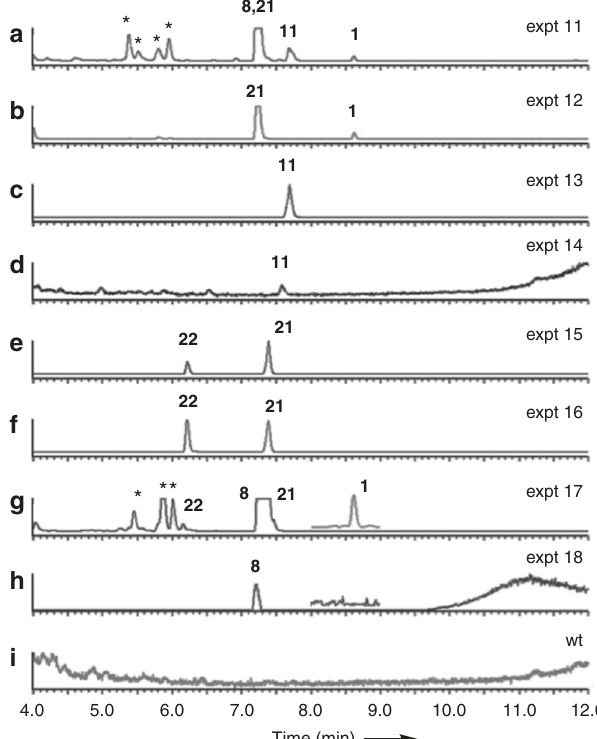
Fig. 6 LCMS evaporative light-scattering (ELS) chromatograms of organic extracts of A. oryzae NSAR1 expression strains (arbitrary units). a A. oryzae NSAR1 + stpks1 + str2 + str3 + str4 + str11 + str8 + str10 + str9 + stl2 ; b A. oryzae NSAR1 + stpks1 + str2 + str3 + str4 + str11 + str8 + str10 + str9 ; c A. oryzae NSAR1 + stpks1 + str2 + str3 + str4 + str11 + str8 + str10 ; d A. oryzae NSAR1 + stpks1 + str2 + str3 + str4 + benzoyl SNAC 9 ; e A. oryzae NSAR1 + stpks1 + str11 + str8 + str10 + str9 + stl2 ; f A. oryzae NSAR1 + stpks1 + str11 + str8 + str10 + str9 ; g A. oryzae NSAR1 + stpks1 + str2 + str3 + str11 + str8 + str10 + str9 , inset trace shows extracted ion chromatogram for m/z 259.1; h A. oryzae NSAR1 + stpks1 + str2 + str3 + str11 + str8 + str10 + str9 + stl2 , inset trace shows extracted ion chromatogram for m/z 259.1; i untransformed A. oryzae NSAR1. *Unrelated compounds. LCMS method